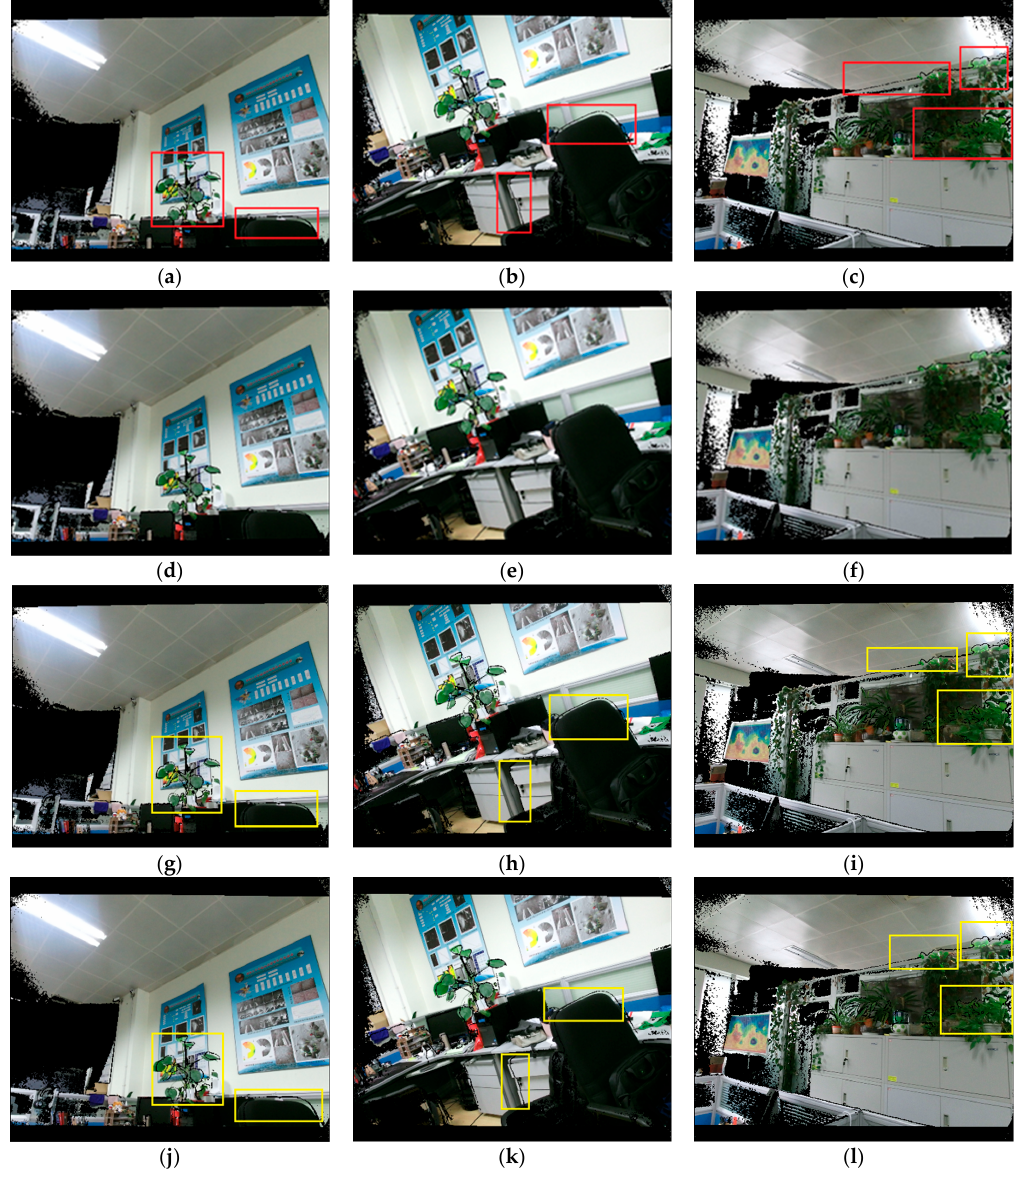
Figure 11. Registration results in different scenes: registration results of different scenes obtained by our method ( d–f ); the corresponding results of [56] ( a – c ); registration results obtained by using the calibrated rotation angles in our model and the translation components of [56] ( g – i ); registration results by using the rotation angles of [56] and the translation components in our model ( j – l ).